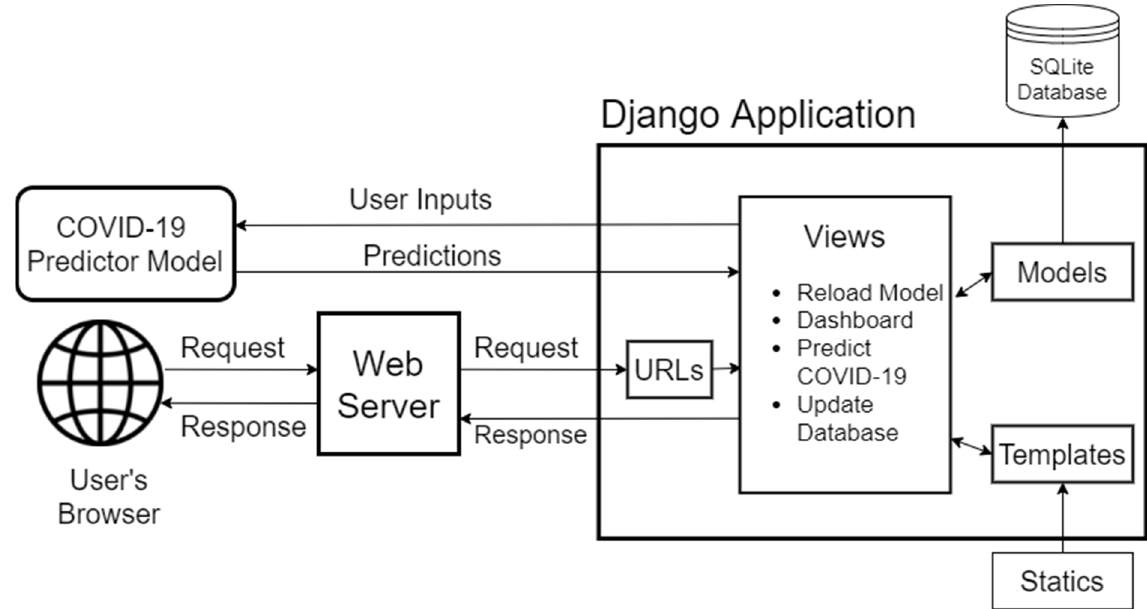
Figure 6. The overall process of the web application development